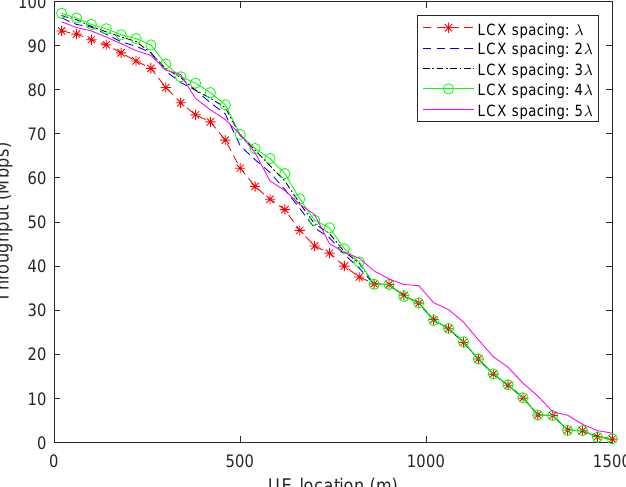
Figure 8. The effect of the LCX spacing interval on the throughput—2T2R (LCXs on the far side).